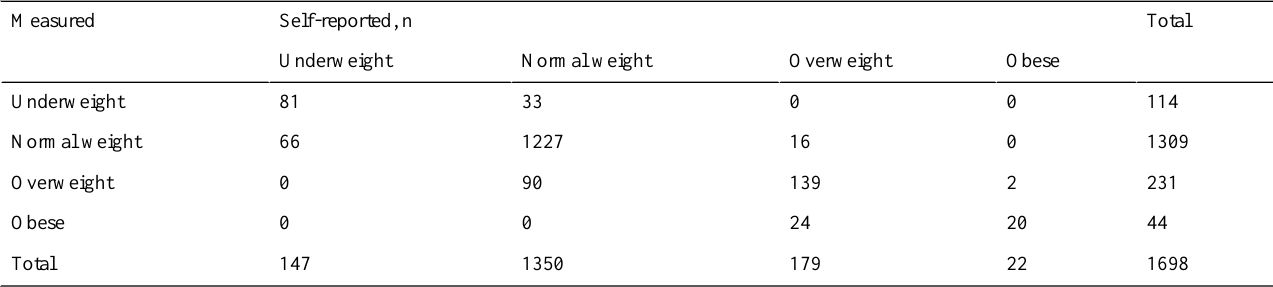
Table 4. Frequencies of children in categories of BMI status according to measured and self-reported weight and